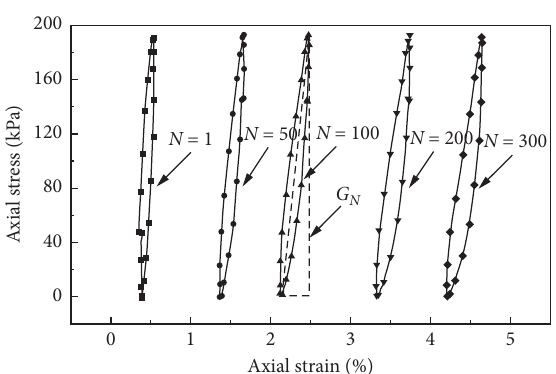
Figure 6: Hysteresis curve of strain softening ( P � 20% ,U � 0 . 80 , σ